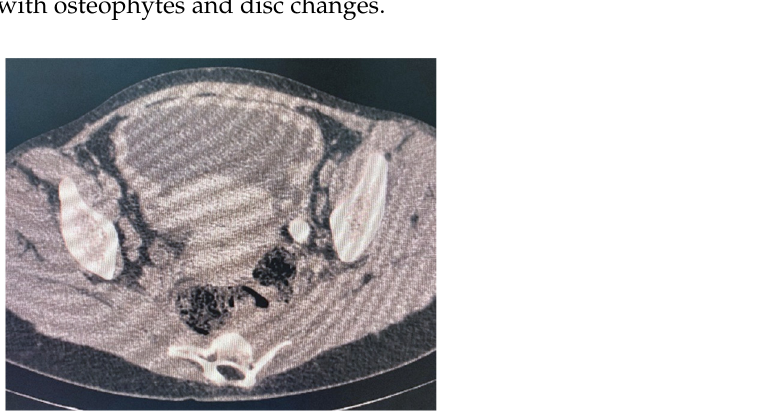
Figure 3. Uro-CT showing an infiltrative contrast enhancing mass located at the level of the posterior bladder wall.